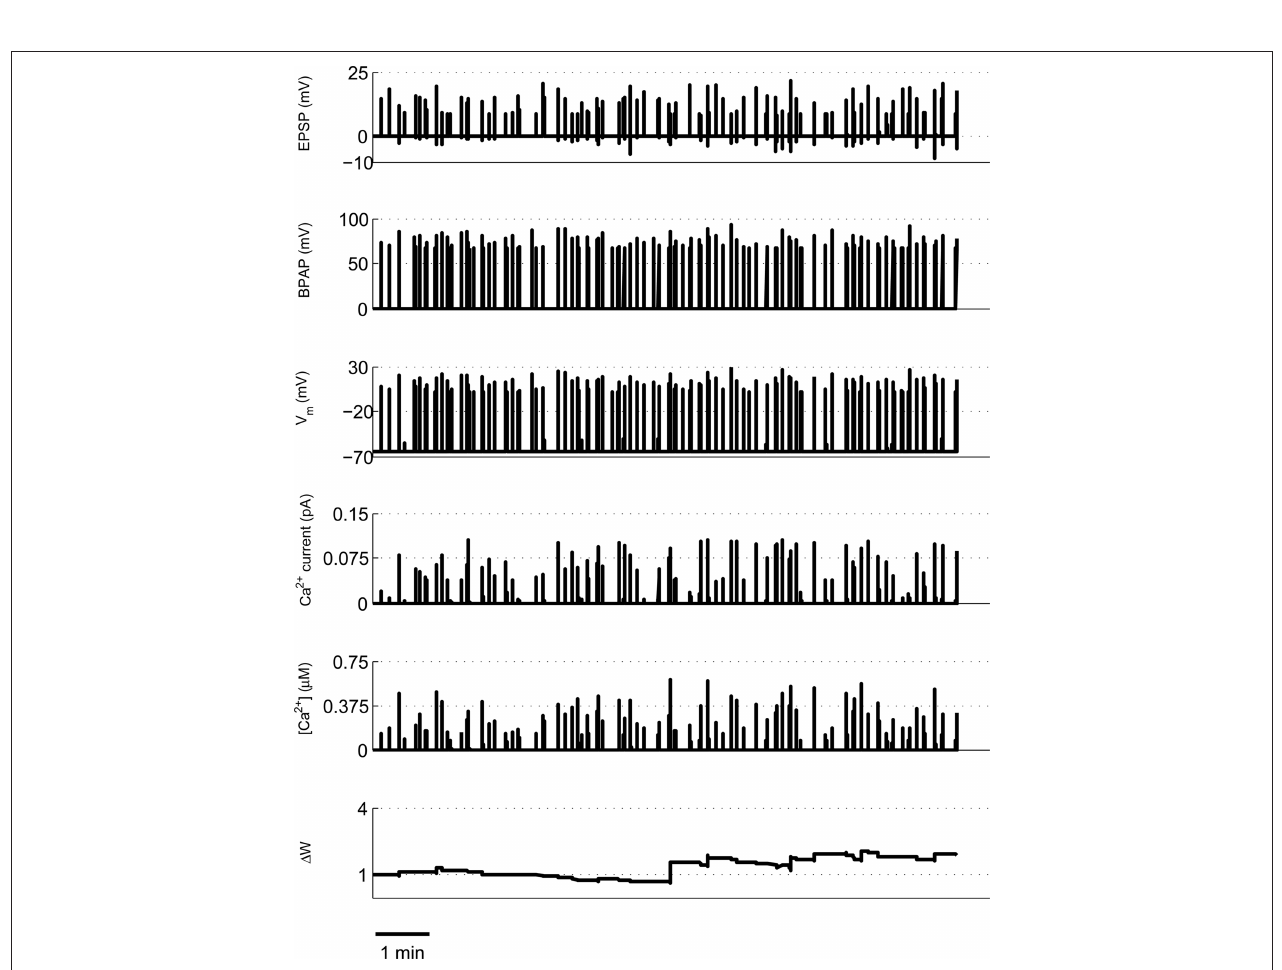
Figure 7 | Spine [Ca 2 + ] determines the direction and magnitude of synaptic weight change. (A) . The Ω− function describes the relationship between peak spine [Ca 2 + ] and synaptic weight change. Symbols represent the peak [Ca 2 + ] produced by a